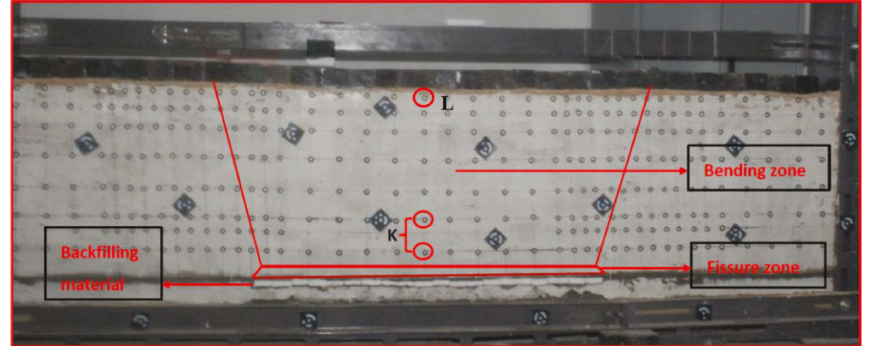
Figure 6: Overburden failure characteristics in model excavation by back fi lling mining.